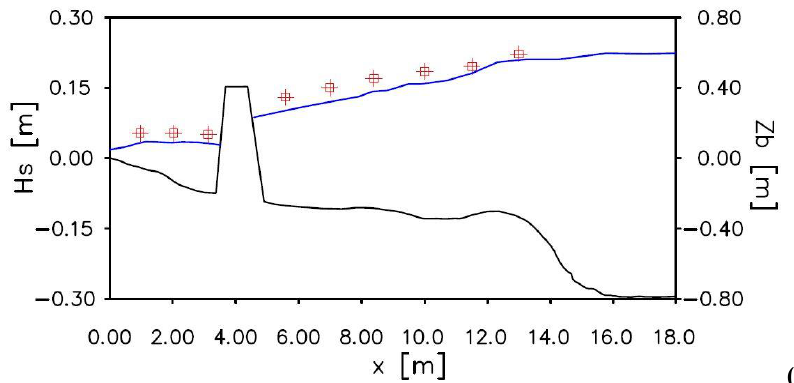
Figure 4. Cross-shore currents: (a) at 𝑦 = 22 𝑚 , (b) at 𝑦 = 26 𝑚 . Comparison between experimental 313 data by Gravens and Wang [22] (red square) and numerical results of the depth-averaged cross-shore 314 currents (blue line). Numerical results of cross-shore currents near the bottom at a relative distance 315 from the free surface 𝑧/𝑧 𝑏 = 0.894 (light green line) and cross-shore currents, near the free surface at 316 a relative distance from the free surface 𝑧/𝑧 𝑏 = 0.081 (green line). Bottom profile in black.